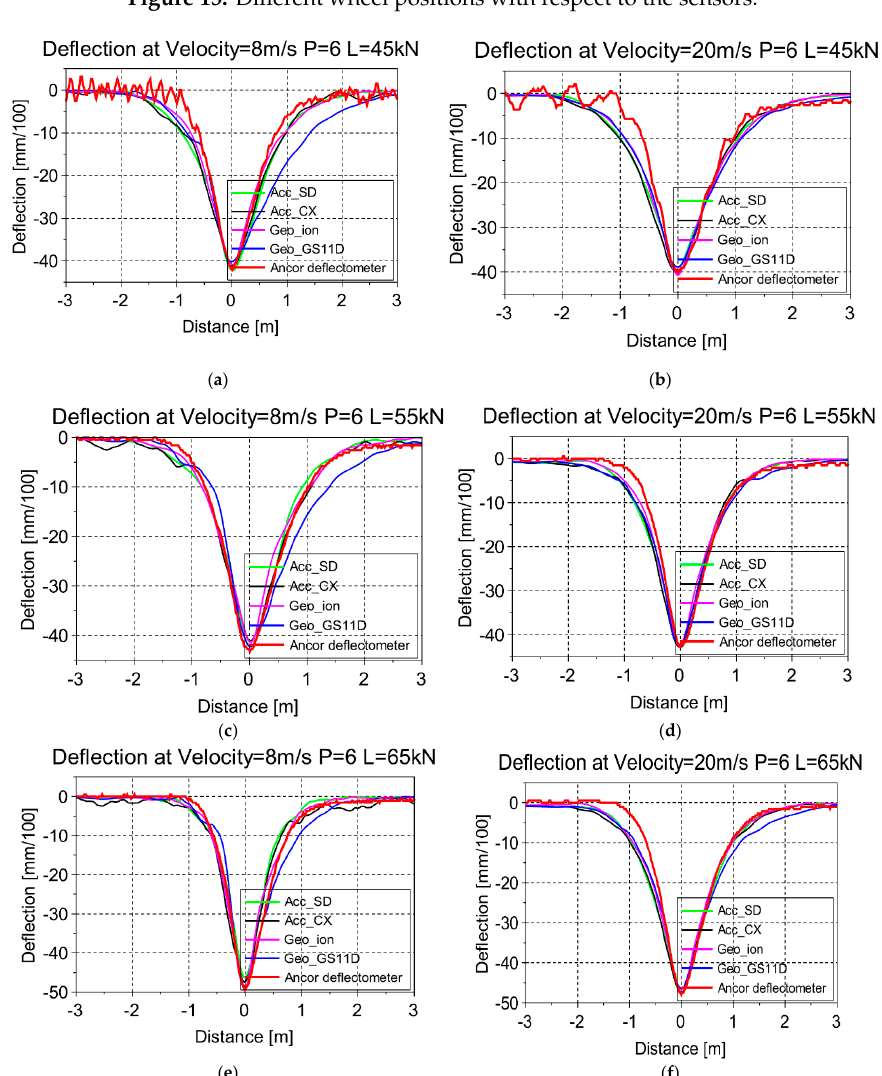
Figure 16. ( a ): Deflection for 45 kN and speed of 8 m / s. ( b ): Deflection for 45 kN and speed of 20 m / s. ( c ): Deflection for 55 kN and speed of 8 m / s. ( d ): Deflection for 55 kN and speed of 20 m / s. ( e ): Deflection for 65 kN and speed of 8 m / s. ( f ): Deflection for 65 kN and speed of 20 m /